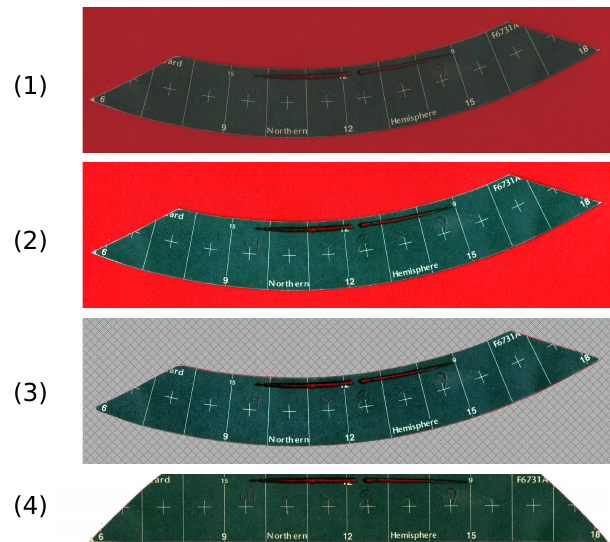
Fig. 2. Schematic illustration of the image capture method. The steps are executed in numerical order and are: (1) capture a quality image – the operator enters meta-data at this point, (2) apply a colour correction using the embedded calibration profile, (3) identify the card within the image, and (4) extract and rectify the card image.